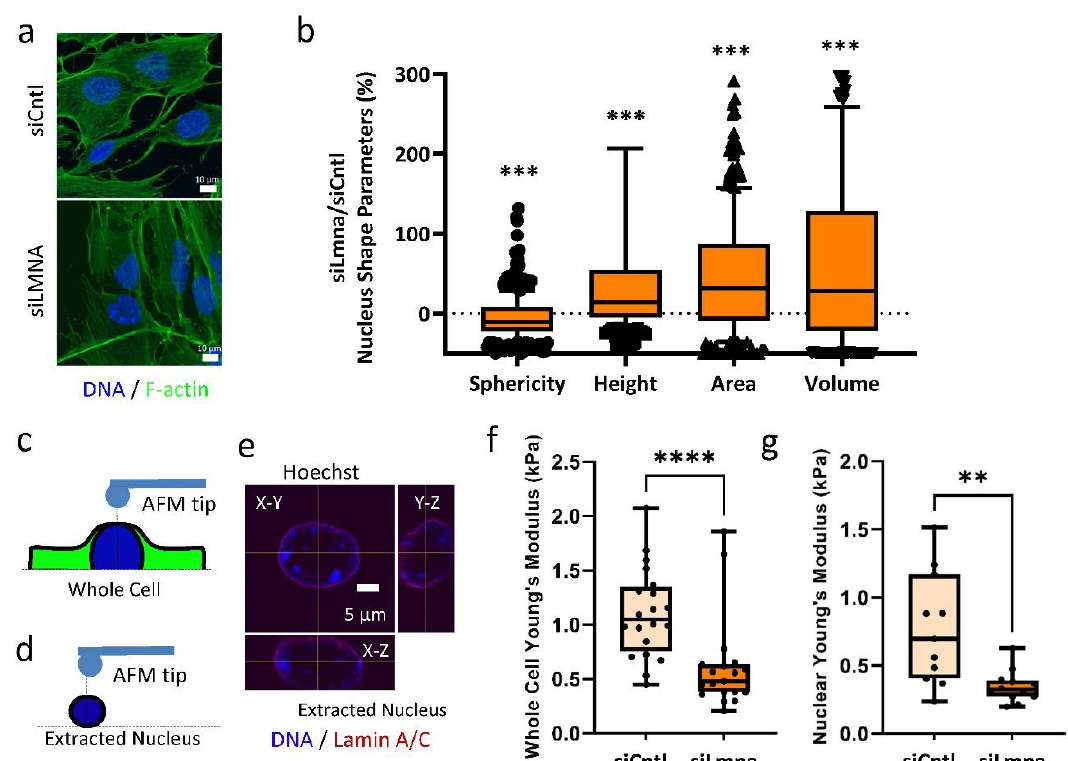
Figure 1. siRNA depletion of lamin A/C weakens the nuclear elastic modulus in MSCs: ( a ) Confocal Image of F-actin (phalloidin, green) and nucleus (Hoechst, blue). Scale bar: 10 µ m. ( b ) Nuclear sphericity decreased by 8% in MSCs treated with Lamin A/C specific siRNA (siLmna) compared to MSCs treated with a non-specific control siRNA (siCntl) ( p < 0.05, n = 342). Nuclear area of siLmna treated cells showed a 32% increase when compared to siCntl ( p < 0.05, n = 342). Nuclear volume siLmna treated cells increased by 31% compared to siCntl ( p < 0.05, n = 342). When compared to the nuclear height of siCntl MSCs, siLmna treated cells had increased nuclear height of 12% ( p < 0.05, n = 342). ( c ) Schematic of AFM probe tip testing whole cell Young’s modulus in live MSCs. ( d ) Depiction of AFM probe tip testing live extracted nucleus. ( e ) Confocal image of extracted nucleus depicting its orthogonal views from X-Y, X-Z, Y-Z planes (Hoechst, blue; Lamin A/C, Red) Scale bar: 5 µ m. ( f ) Whole cell Young’s modulus of the siLmna group was 45% lower when compared to the siCntl group ( p < 0.0001, n = 16). ( g ) Young’s modulus of extracted live nucleus in siLmna MSCs remained 55% lower when compared to siCntl MSCs ( p < 0.01, n = 13). Results are presented as mean ± STD. Group comparisons were made via non-parametric Mann Whitney tests. p < 0.05, ** p < 0.01, *** p < 0.001, **** p < 0.0001 against